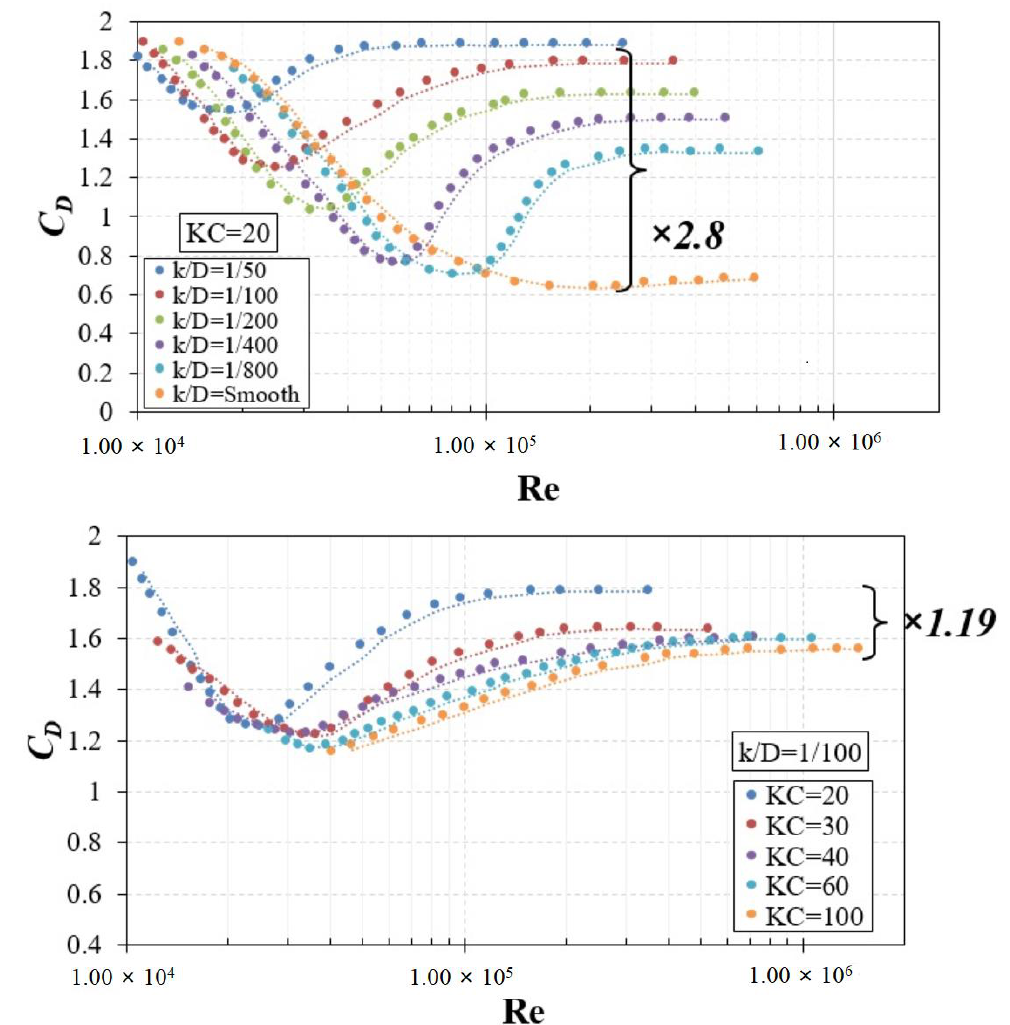
Figure 3. Drag coefficient for a fixed circular cylinder for steady flow in critical flow regime, for various roughness ratios (rebuilt with data from [16]).